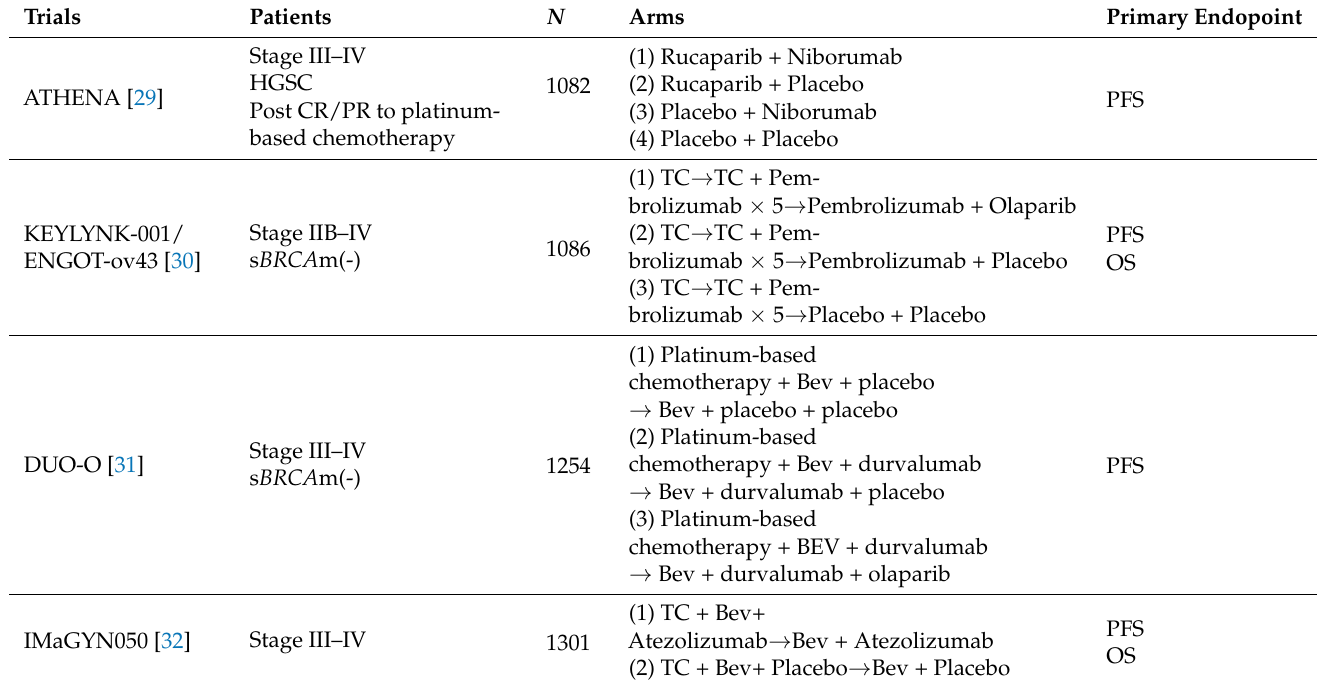
Table 5. Ongoing clinical trials of first maintenance therapy using checkpoint